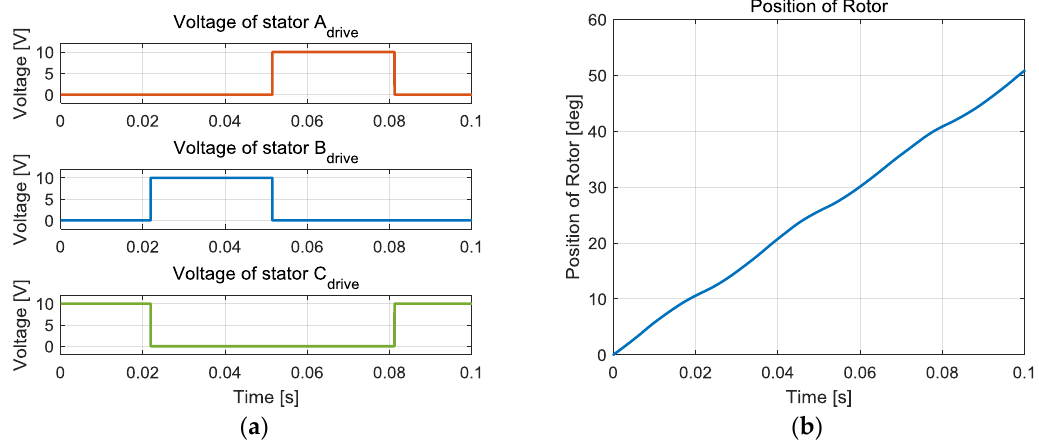
Figure 3. Example of open loop operation: ( a ) Input voltage, ( b ) Rotor position.